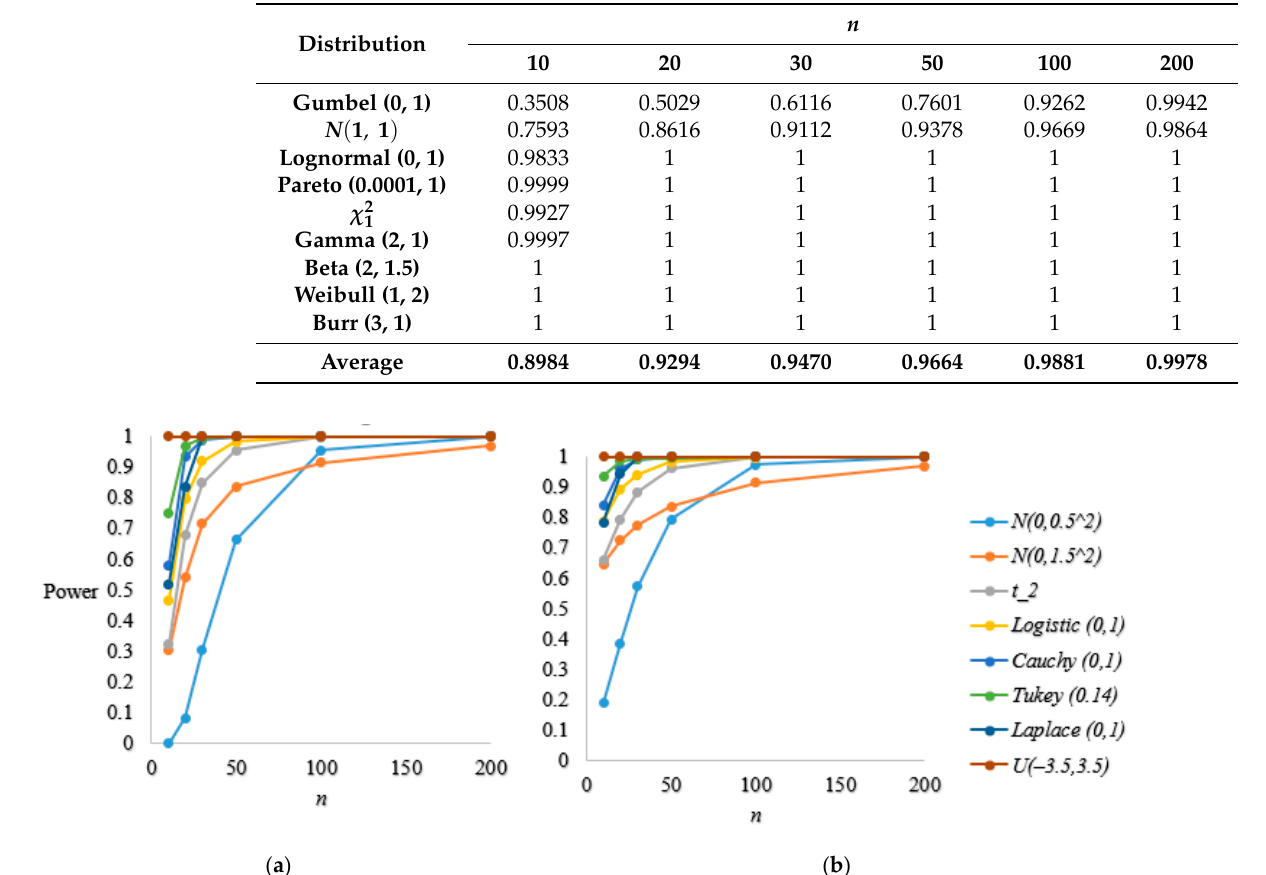
Table 6. Empirical power of statistic V n where parameters are estimated for various sample sizes with the level of significance α = 0.05 —Asymmetric alternative distributions.